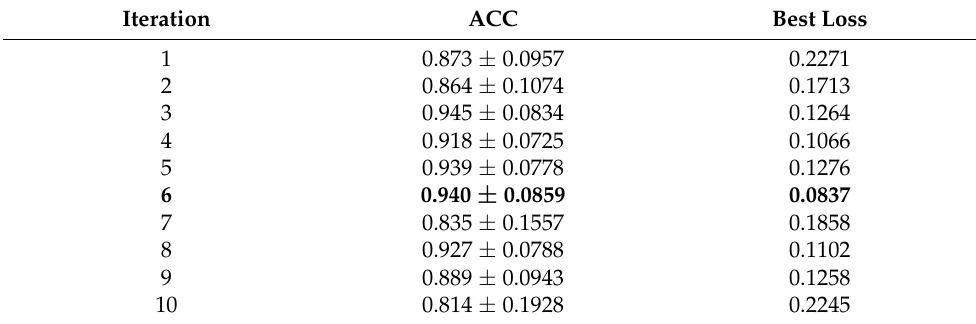
Table 2. Stratified 10-fold cross-validation results with ECFP4 over ten iterations. Iteration